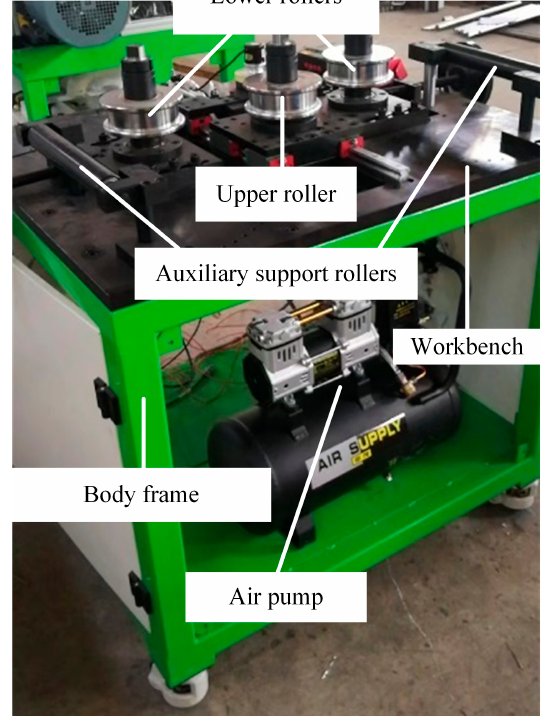
Figure 8. Horizontal symmetrical three-roll roll bending machine.